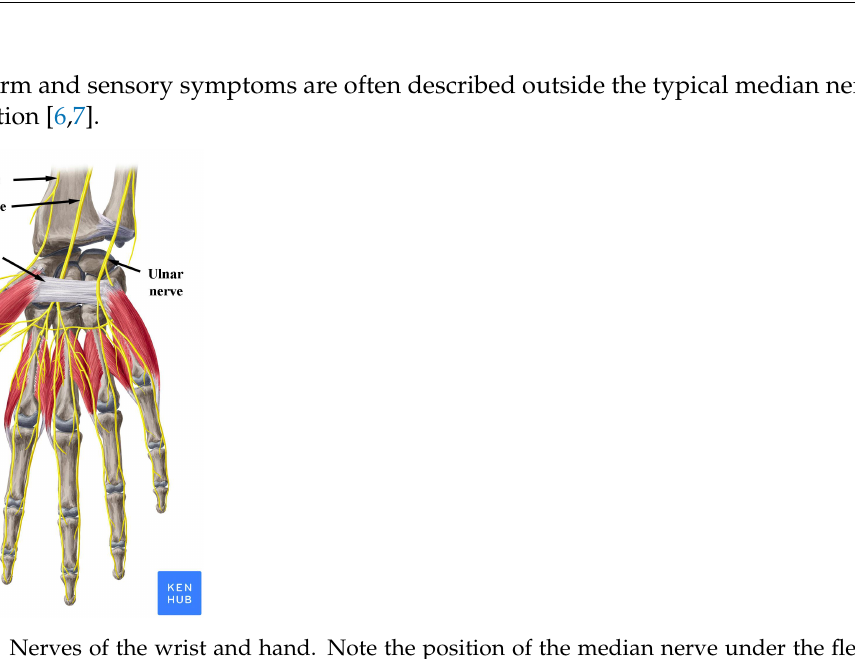
Figure 1. Nerves of the wrist and hand. Note the position of the median nerve under the flexor retinaculum. Reproduced with permission from www.kenhub.com, accessed on 1 August